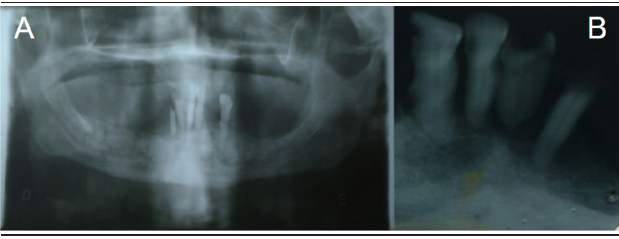
FIGURA 3 – Exame de